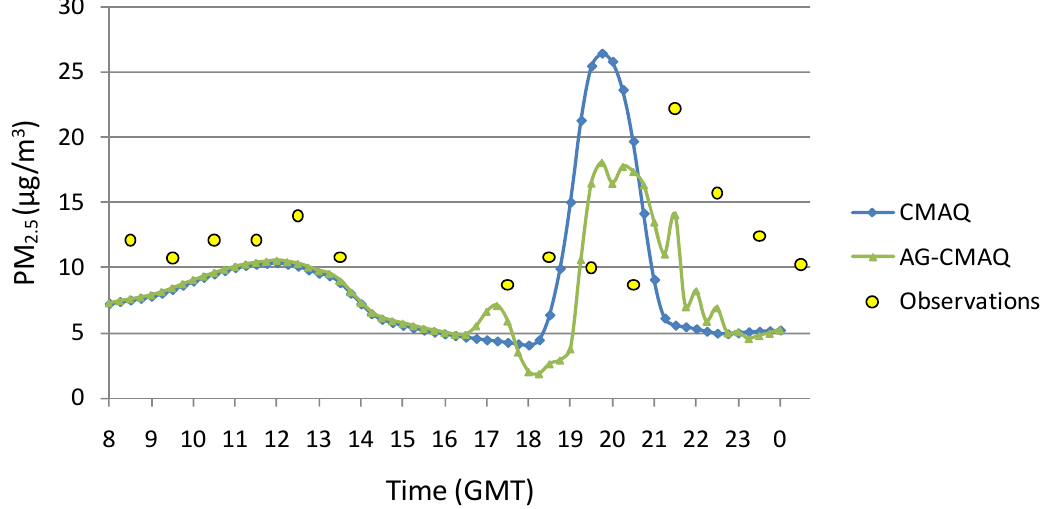
concentrations ( μ gm − 3 ) as observed and modeled Figure 17. Hourly averaged PM 2.5 by CMAQ and AG-CMAQ at the Columbus airport air quality monitoring site on April 9,